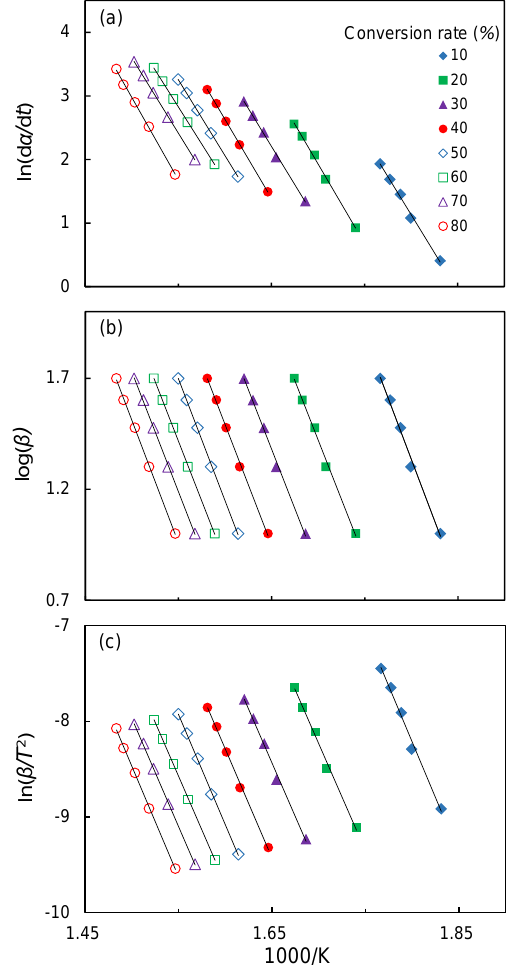
Figure 5. Typical isoconversional plots using the Friedman method ( a ); Flynn-Wall-Ozawa method ( b ); and Modified Coats-Redfern method ( c ) for Chinese